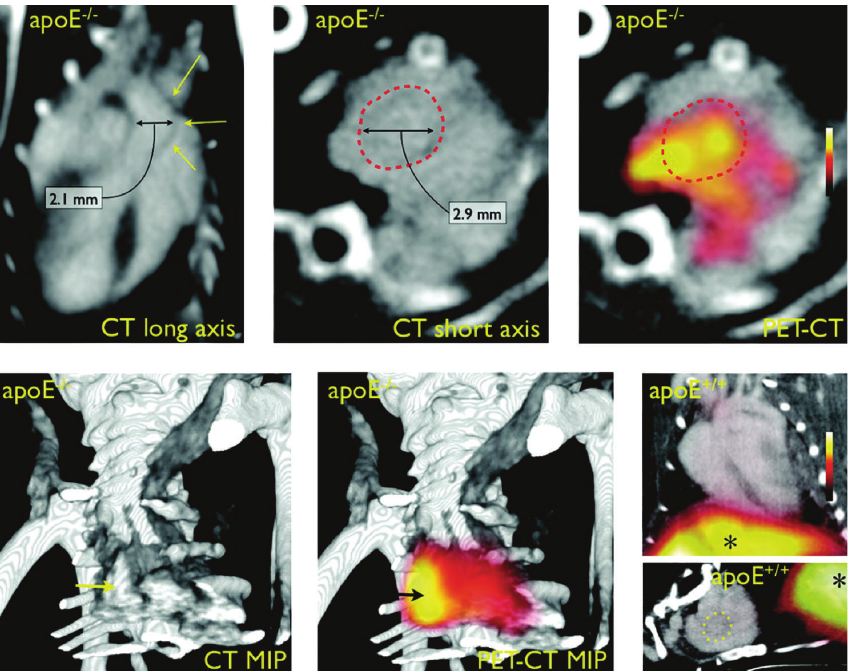
Figure 6: PET/CT imaging in mice with aortic aneurysms induced via angiotensin II infusion. Apolipoprotein E-deficient (apoE −/− ) mice were compared to wild-type controls (apoE +/+ ). Dotted lines and yellow arrows outline the aneurysmal aorta. Liver signal highlighted with ( ∗ ). PET/CT images illustrate the ability of CT to add anatomical context for PET images. Figure adapted from